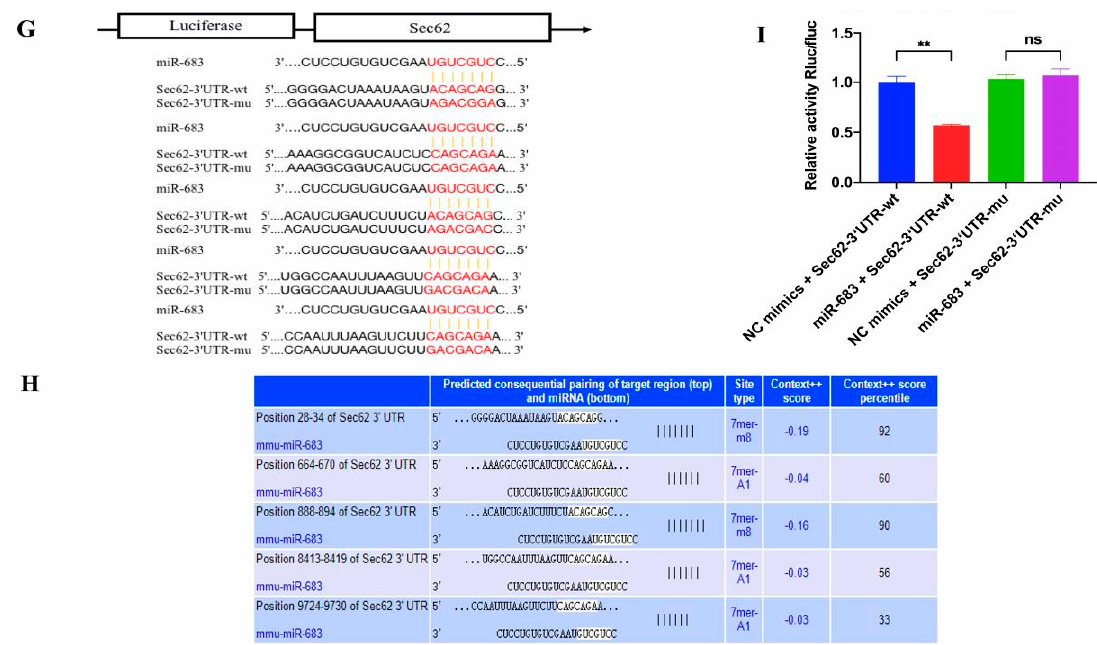
Figure 5. CircMaml2 Sponges miR-683. ( A ) Bioinformatics software predicted the binding sites for circMaml2 and miR-683. ( B ) Schematic illustration of circMmal2-WT and circMmal2-Mut luciferase reporter vectors. ( C ) Relative luciferase activities were investigated in MC38.wt cells after transfection with circMmal2-WT or circMmal2-Mut and miR-683 mimics or miR-NC (**** p < 0.0001, ordinary one-way ANOVA). ( D ) Relative miR-683 expression after circMaml2 overexpression (* p = 0.0494, t test). ( E ) Fifty four possible genes of functional targets of miR-683 were indicated by a Venn diagram. ( F ) MiR-683 dramatically inhibited Sec62 was detected by qRT-PCR. ( G ) TargetScanMouse was used to predict the sequence between miR-683 and Sec62. ( H ) The mutant binding sites of miR-683 at the 3 ′ UTR of Sec62 mRNA. ( I ) Relative luciferase activities of Sec62 − 3 ′ UTR-wt or Sec62 − 3 ′ UTR-mut were analyzed ( n = 3) (** p = 0.0011, ordinary one-way ANOVA). All data are presented as mean + SEM. ns, not significant. n = 3.